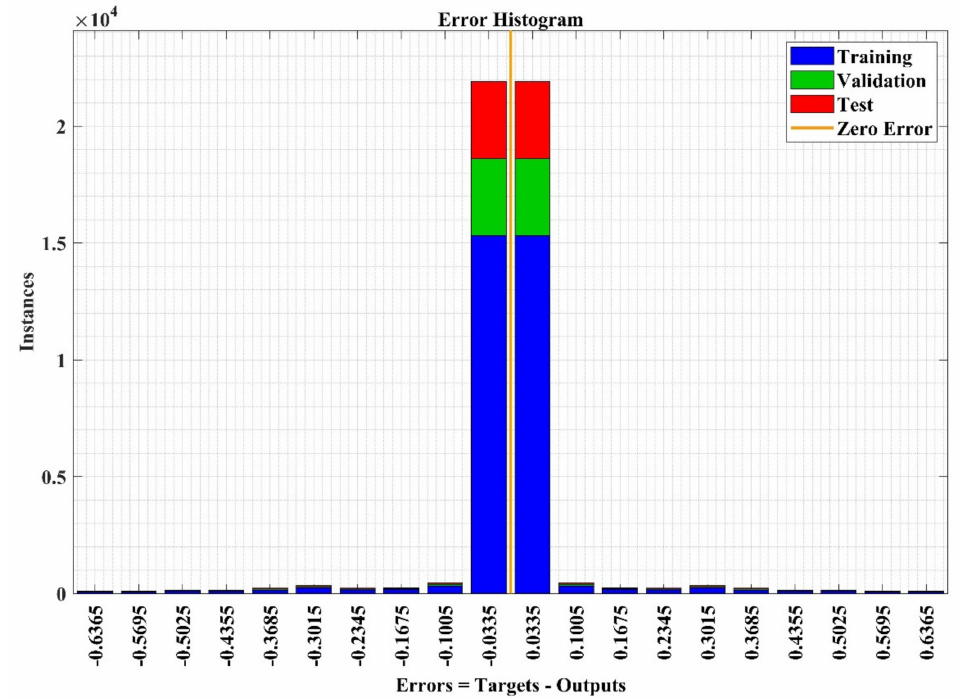
Figure 20. NN error analysis plot for the training phase of the model.